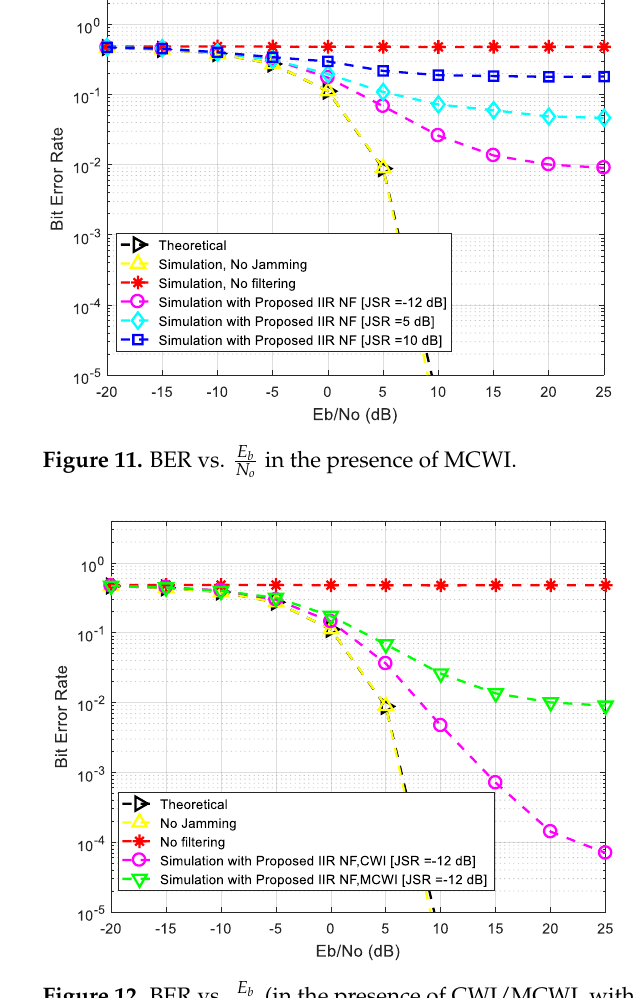
Figure 12. BER vs. E b N o (in the presence of CWI/MCWI, with JSR = − 12 dB).